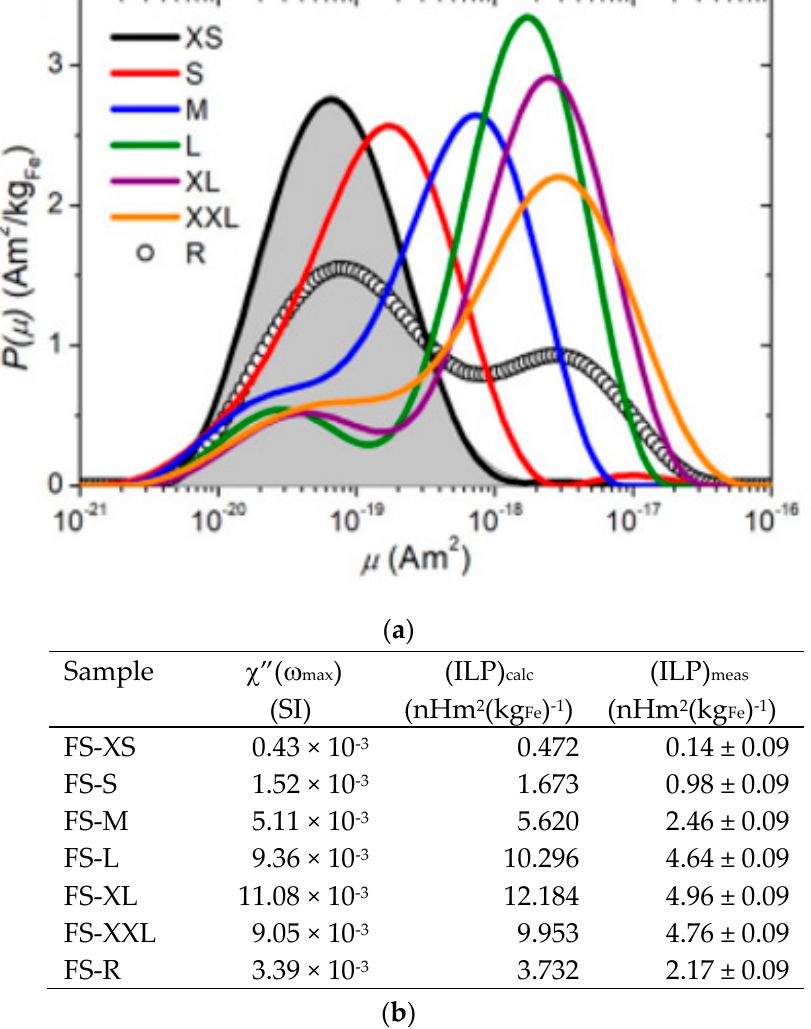
Figure 30. ( a ) FeraSpin MMC magnetic moment distributions determined from DC magnetization data: discrete moment-weighted apparent moment distributions P( µ ) = M sp ( µ ) ∆ µ of the colloids determined by numerical inversion of the M(H) curves. The gray area is the transformed and rescaled distribution calculated for a number-weighted lognormal distribution p( µ ) with σ = 1.1 and a mean value of ‹ µ › = 3.6 × 10 − 20 A m 2 and ( b ) Intrinsic Loss Power of FerraSpin-R fractionated MMCs (republished with permission of IOP Publishing, from [279]; permission conveyed through Copyright Clearance Center, Inc.).